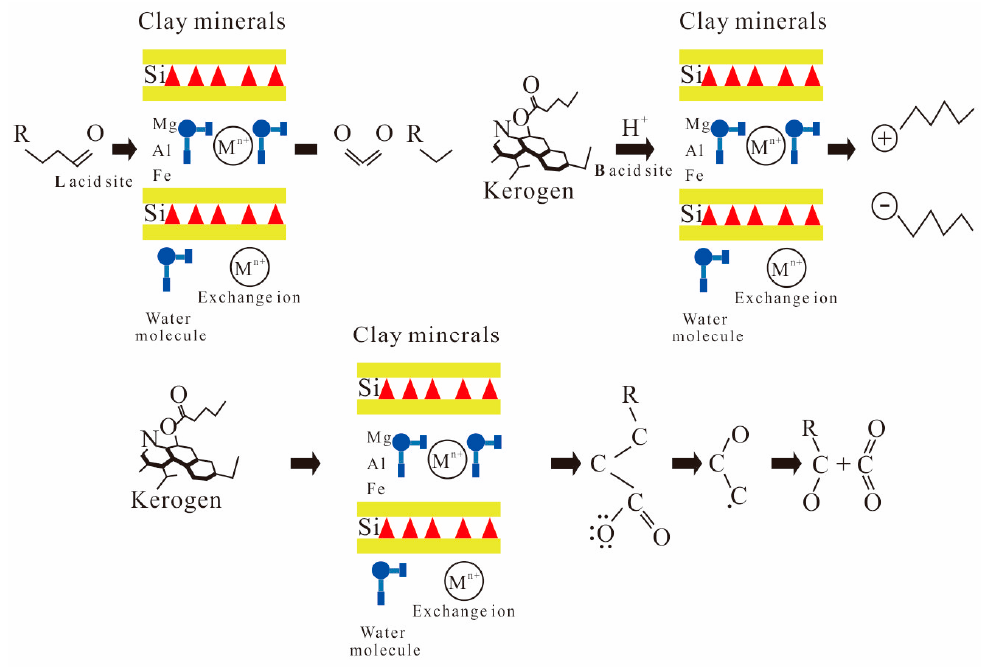
Figure 1. The main catalytic mechanism of clay minerals.